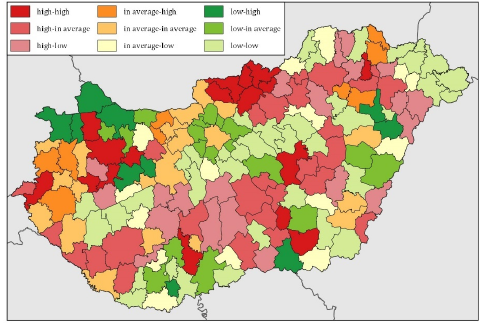
Figure 10: The spatial concentration of deaths (first term) and infected (second term) people at the micro-regional level in Hungary (LAU 1) between 4 March 2020 and 14 February 2021